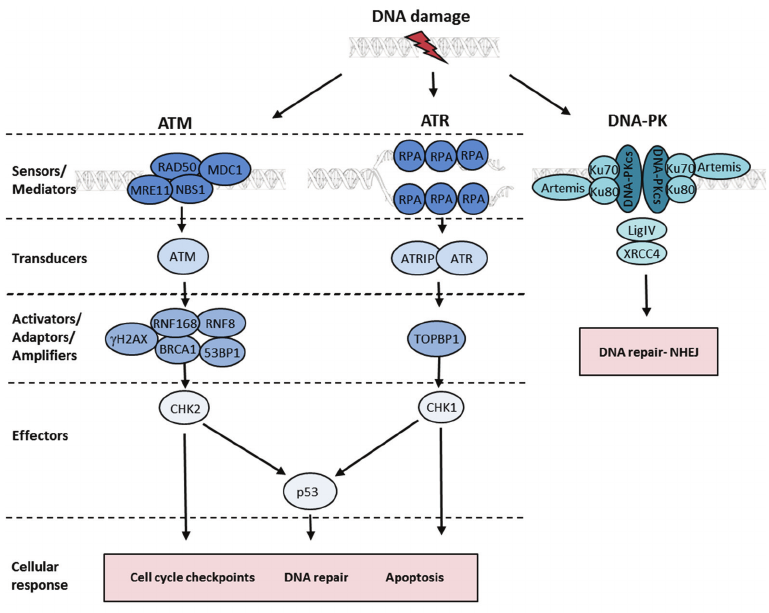
Figure 1. ATM, ATR and DNA-PK signalling pathways. The DNA damage signalling pathways are primarily mediated by the ATM, ATR and DNA-PK kinases. DSBs are detected by the MRN complex (MRE11, RAD50 and NBS1) which recruits and activates ATM at the site of the break. Activated ATM phosphorylates numerous effector proteins such as CHK2 and p53. Phosphorylation of the histone variant H2AX by ATM and ubiquitination of H2AX by RNF8 and RNF168 E3 ubiquitin ligases precedes recruitment of repair proteins such as BRCA1 and 53BP1. ATR is primarily activated at regions of ssDNA which are first coated by RPA. ATR is then recruited to RPA-coated ssDNA via its interacting protein ATRIP. The recruitment of TOPBP1 to the ssDNA region is responsible for the activation of ATR which subsequently phosphorylates effector proteins such as CHK1 and p53. In contrast to the ATM and ATR kinases, DNA-PK is responsible for the regulation of the NHEJ DSB repair pathway. Image adapted from [13].